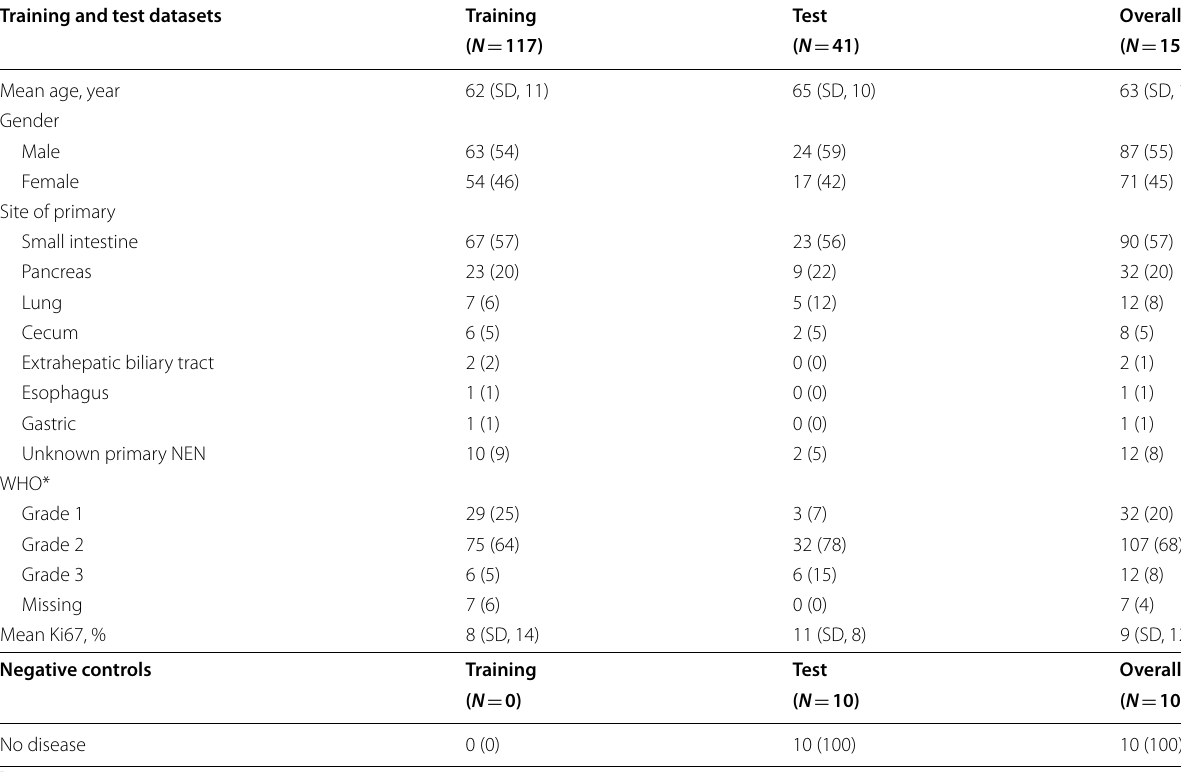
Table 2 Demographic data for patients with neuroendocrine neoplasms Training and test